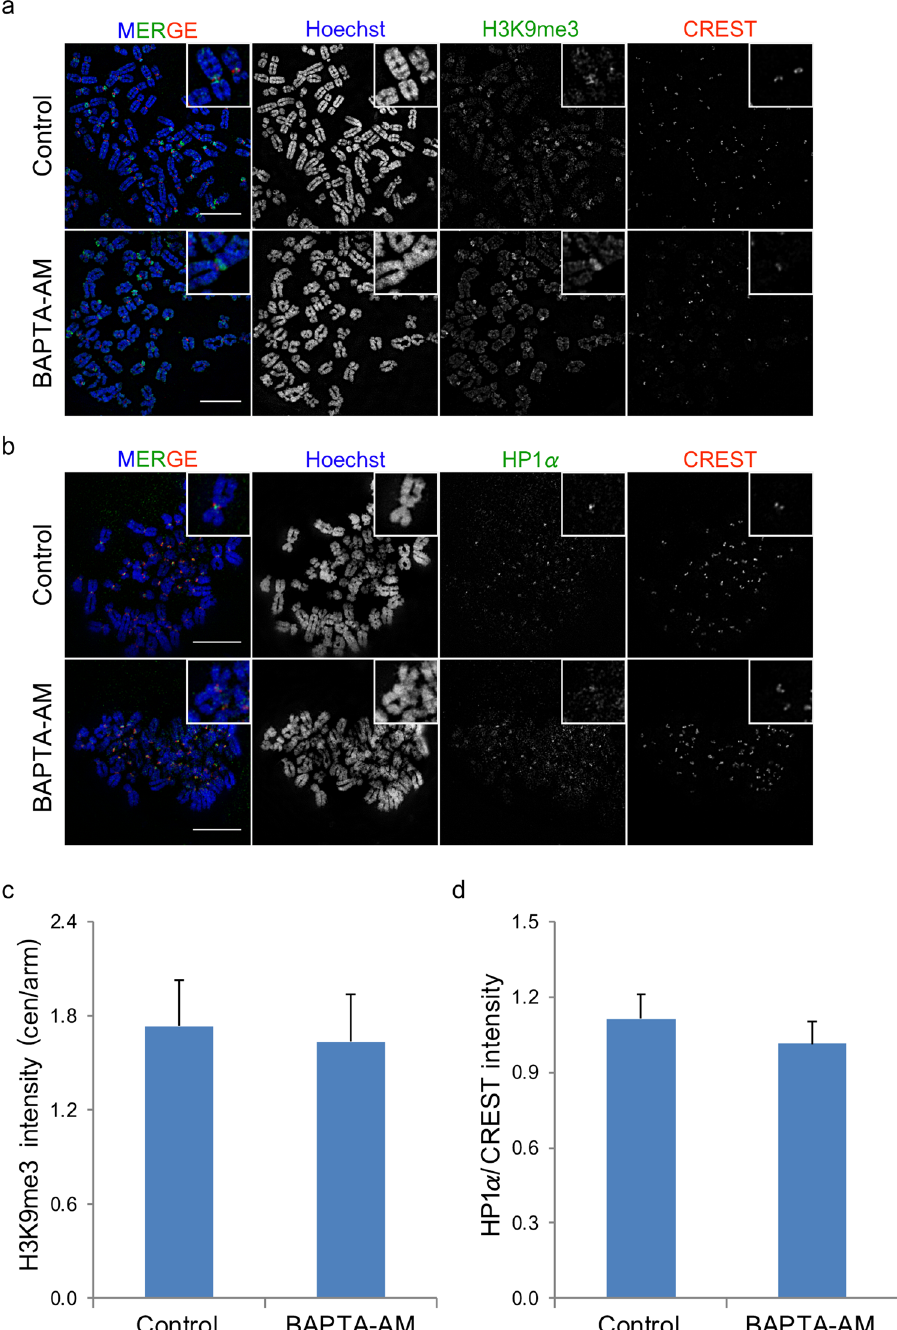
Figure 3. Ca 2 + -depletion does not alter H3K9me3 and HP1 α localisation. Fluorescence images of chromosome spreads prepared from control and BAPTA-AM treated cells for the localisation of H3K9me3 ( a ) and HP1 α ( b ). Bar graphs below indicate H3K9me3 centromere-to-arm signal intensity ( c ) and HP1 α /CREST signal intensity ( d ). Error bars indicate standard deviations derived from three independent experiments. Bar, 5 µ